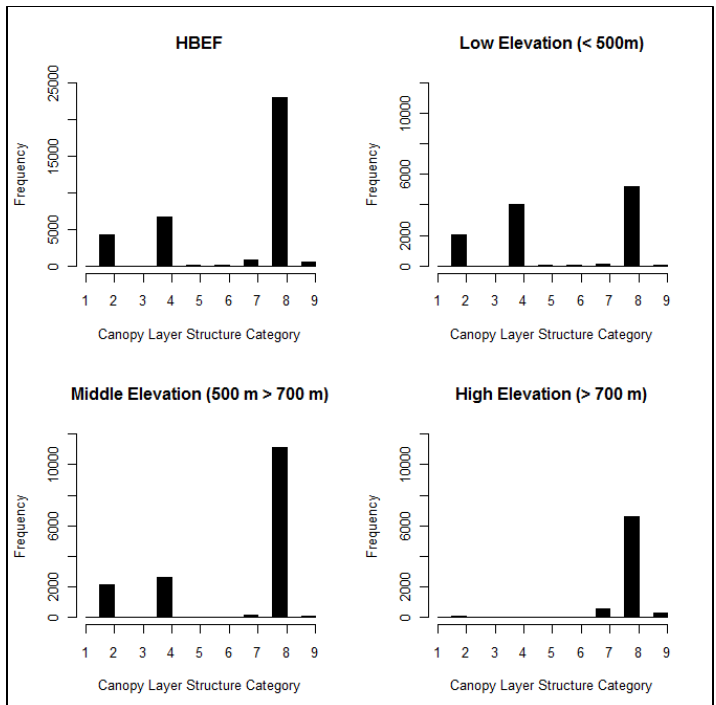
Figure 7. Histogram of canopy layer structure categories showing the number of pixels in each canopy layer structure category for all of HBEF (upper left) as well as at the low, middle, and high elevation levels.